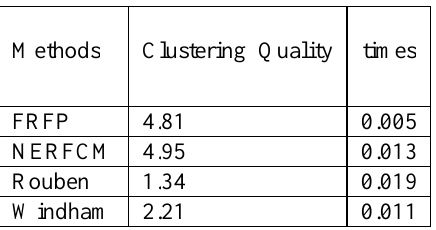
Table 3 Average quality measures and execution times for clustering using proximity matrix 1